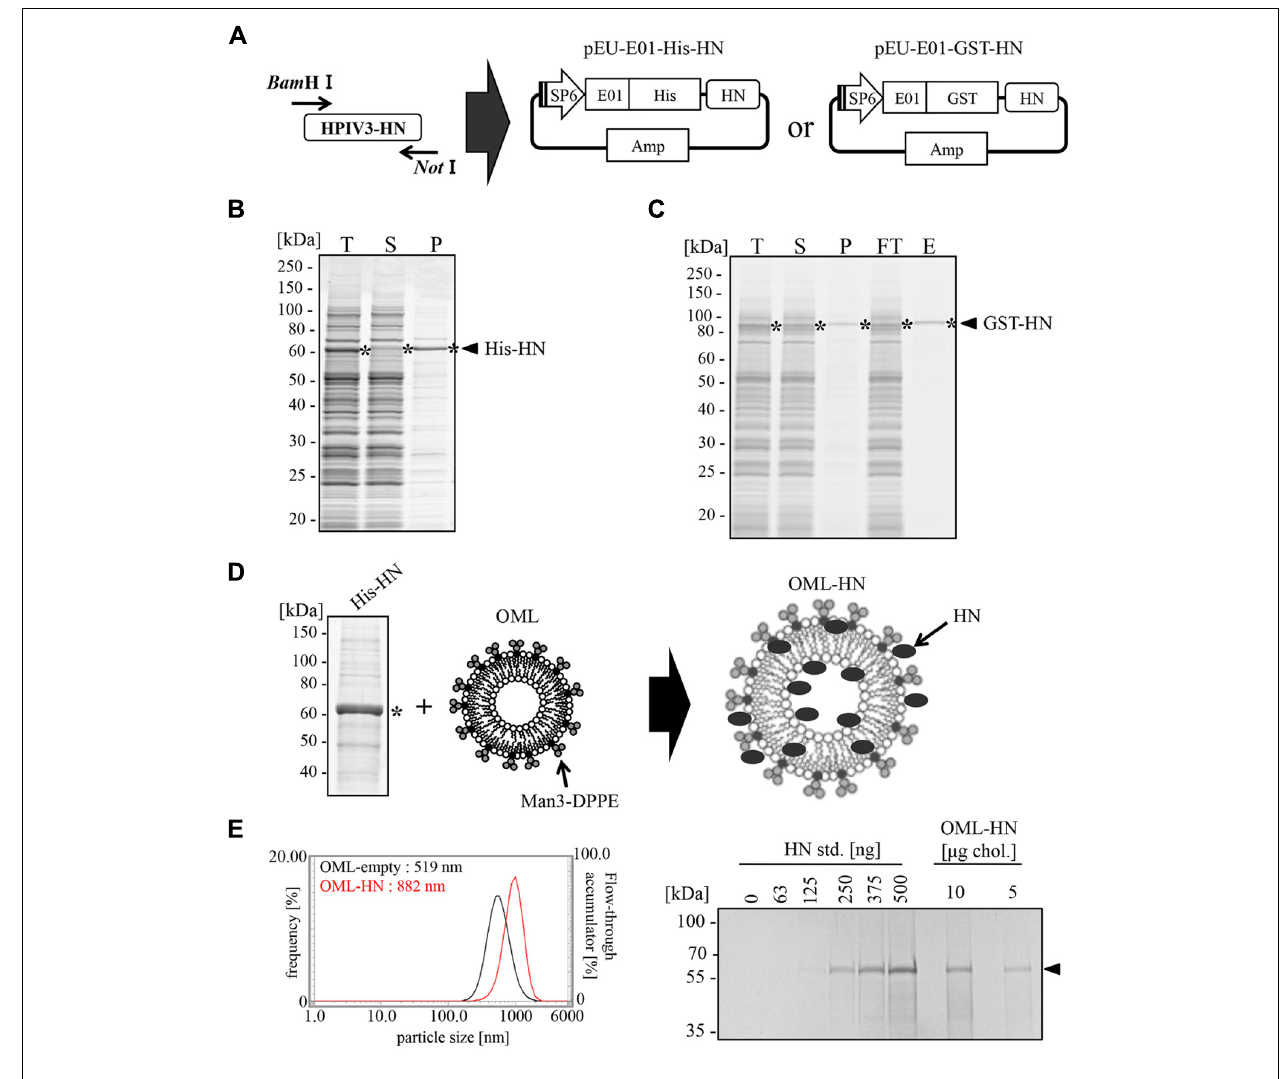
the wheat germ cell-free system. The translation mixture (T) was subjected to the separation into supernatant (S) and precipitate (P) fractions by centrifugation. GST-HN proteins were purified using glutathione sepharose bead and then resolved by SDS-PAGE and CBB staining. The single asterisk indicates the band of GST-HN. FT, Flow through fraction; E, elute fraction. (D) Schematic of the production of OML-encapsulated His-HN. The single asterisk indicates the band of His-HN. (E) The amount of encapsulated HN was quantitated by SDS-PAGE (right panel). The diameter of OML-HN or control OML were measured by dynamic light scattering particle size analyzer (left panel). The arrow indicates the band of